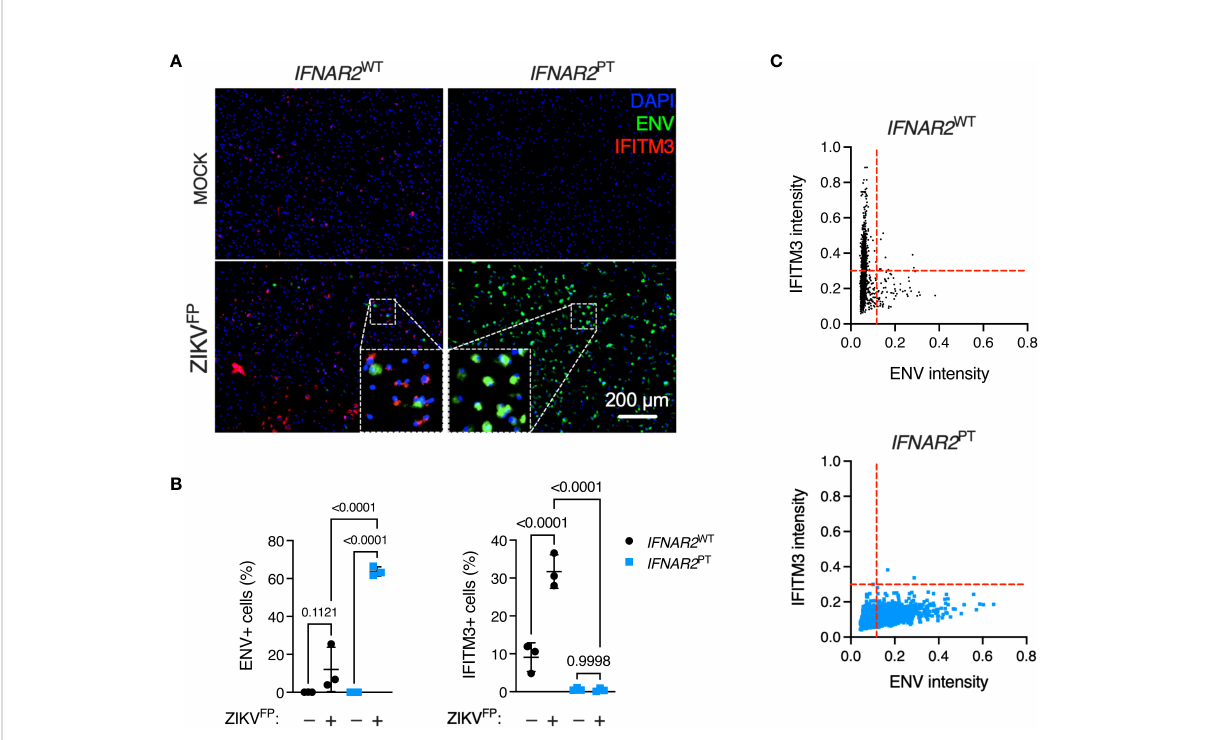
FIGURE 4 IFN-I mediates paracrine protection of iPS-macrophages. (A) Immuno fl uorescence analysis of ZIKV ENV and IFITM3 expression in IFNAR2 PT (clone 11) and IFNAR2 WT (WT2) iPS-M f (24 h.p.i. ZIKV FP MOI = 10.0). Representative images from one of three independent experiments are shown. Scale bar = 200 m m. (B) CellPro fi ler quanti fi cation of images in (A) showing proportion of cells expressing ZIKV ENV (left panel) or the ISG IFITM3 (right panel). Mean ± SD of n = 3 independent experiments, ANOVA with Sidak ’ s test for multiple comparisons. (C) CellPro fi ler analysis of single cell expression of ENV and IFITM3 in IFNAR2 WT and IFNAR2 PT iPS-M f from images in (A) , n = 2,434 (WT) cells and n = 2,202 (PT) cells respectively. Red dotted lines represent gating. Representative data from one of three independent